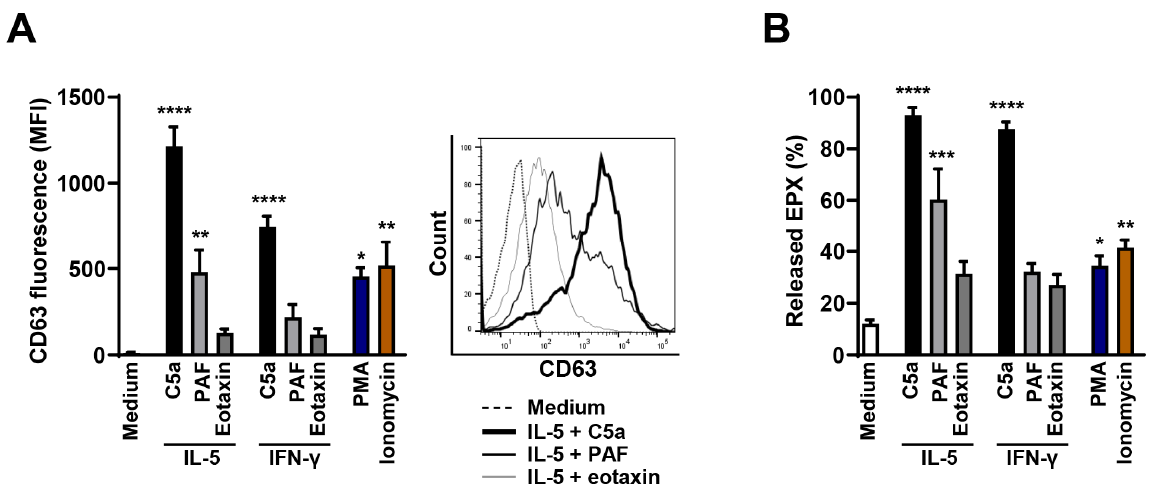
Figure 1. Degranulation of human eosinophils following different stimuli. ( A ) Flow cytometry. Human eosinophils were primed with IL-5 or IFN- γ for 20 min, and subsequently stimulated with C5a, PAF, or eotaxin for 15 min. Unprimed eosinophils were incubated with PMA or ionomycin for 15 min. Eosinophil degranulation was assessed by CD63 surface expression by flow cytometry ( n = 3). Right : A representative histogram of flow cytometry data is shown. ( B ) EPX assay. Human eosinophils were treated as described in (A). Released eosinophil granule protein EPX in the cell supernatant was measured by absorbance at 492 nm ( n = 3). Values are means ± SEM. * p < 0.05; ** p < 0.01; *** p < 0.001; **** p < 0.0001.